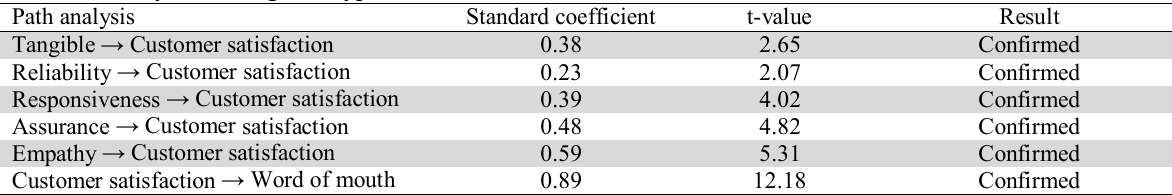
The summary of testing the